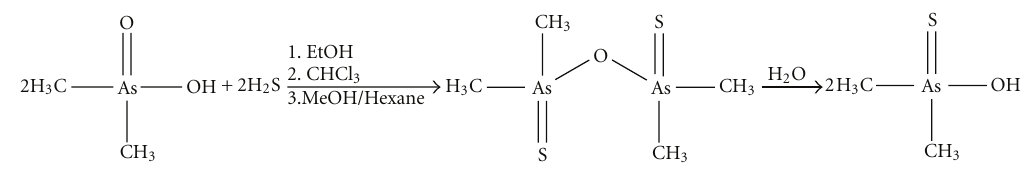
Figure 1: Scheme of the synthesis of dimethylthioarsinic anhydride and its conversion into the acid form thio-DMA V in water.